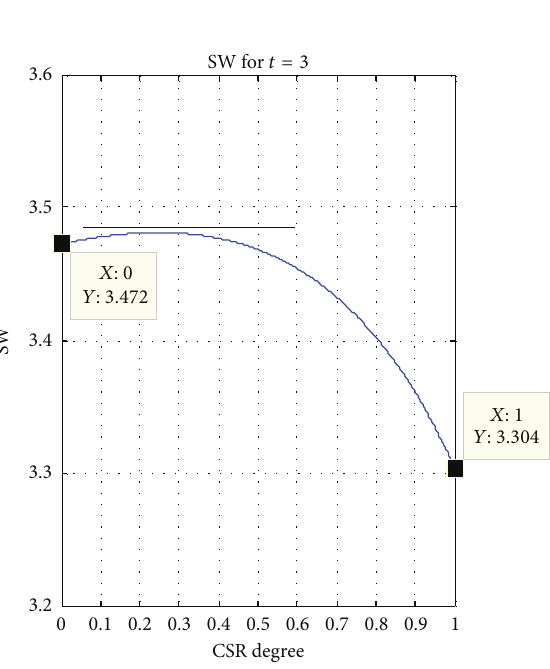
Figure 1: Social welfare for 𝑡 = 2 .